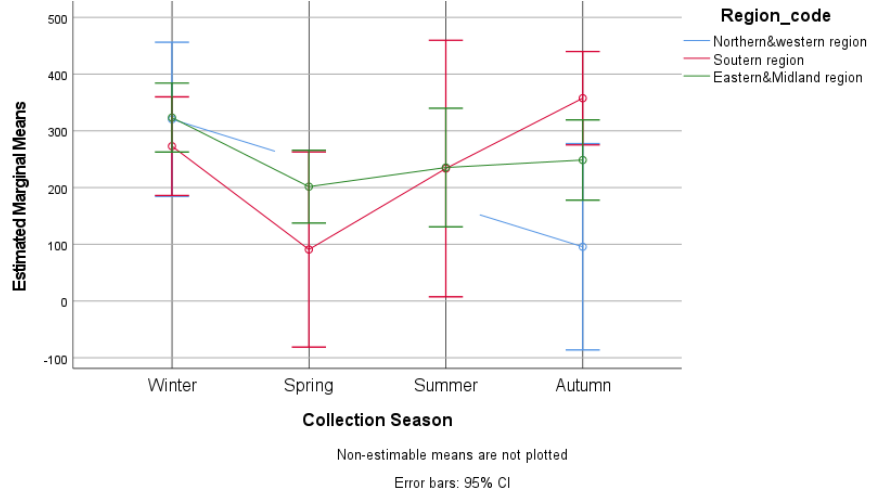
Figure 4. Estimated marginal mean strongyle eggs per gram for different collection seasons and geographical regions in Ireland.